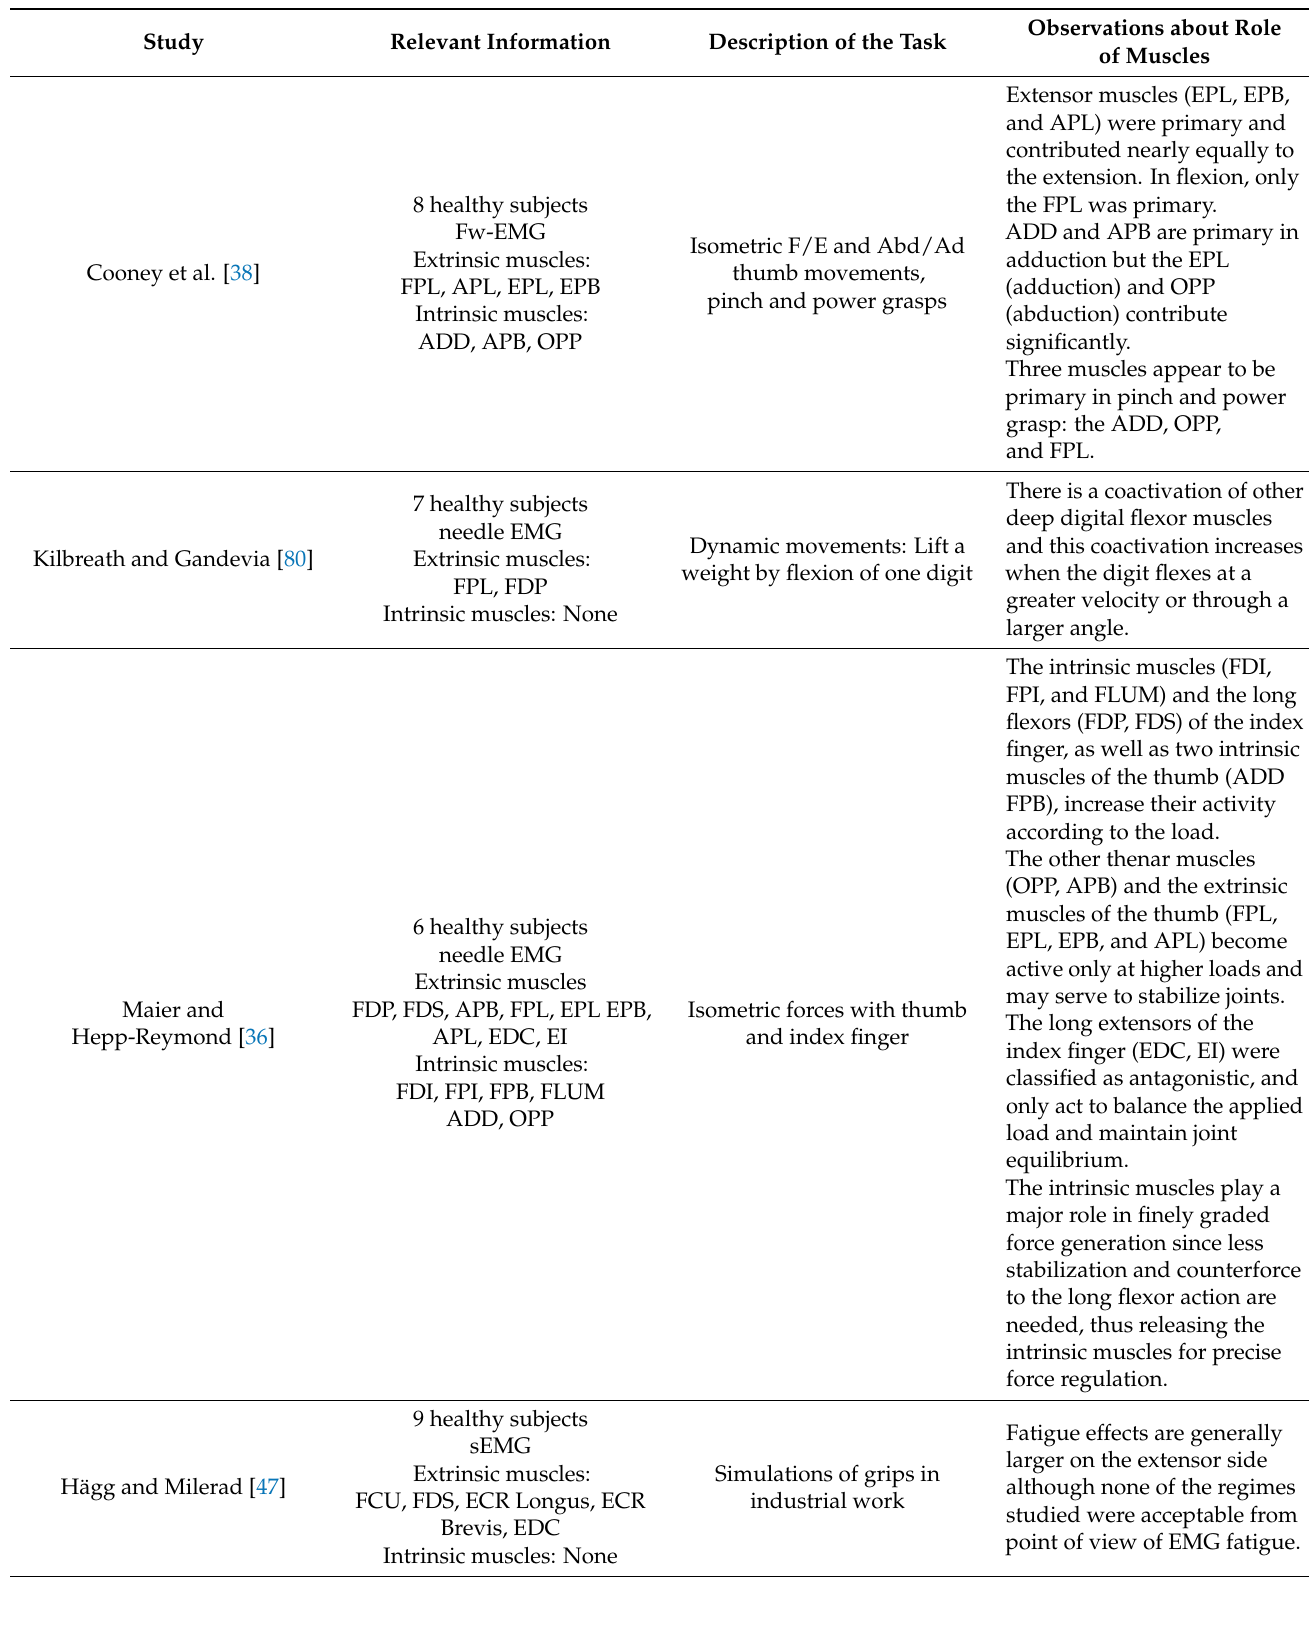
Table 1. Summary of the studies included in the systematic literature review (I). Relevant information contains subjects, type of EMG used, and muscles recorded in the